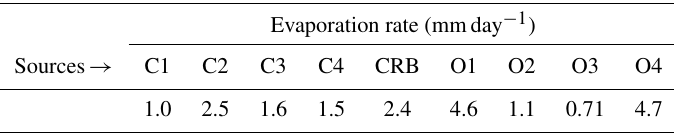
Table 1. Mean annual evaporation rate over the sources. The data for the continent were obtained from GLEAM and those for the ocean from